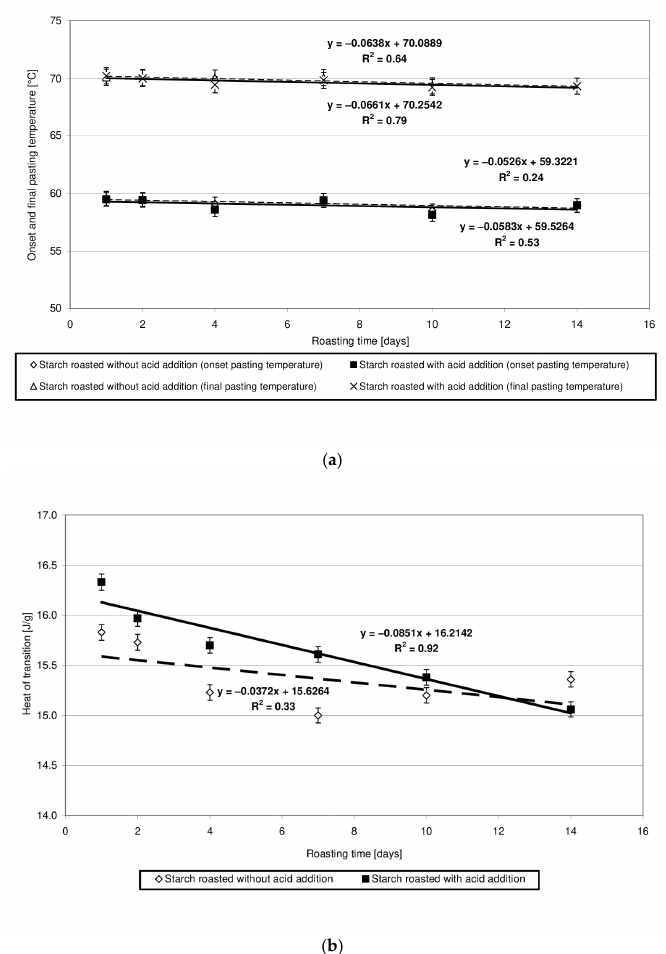
Figure 5. ( a ) Dependency of the onset and final pasting temperature on the time of starch retention with and without citric acid. ( b ) Dependency of the heat of transition on the time of starch reten- tion with and without citric acid.